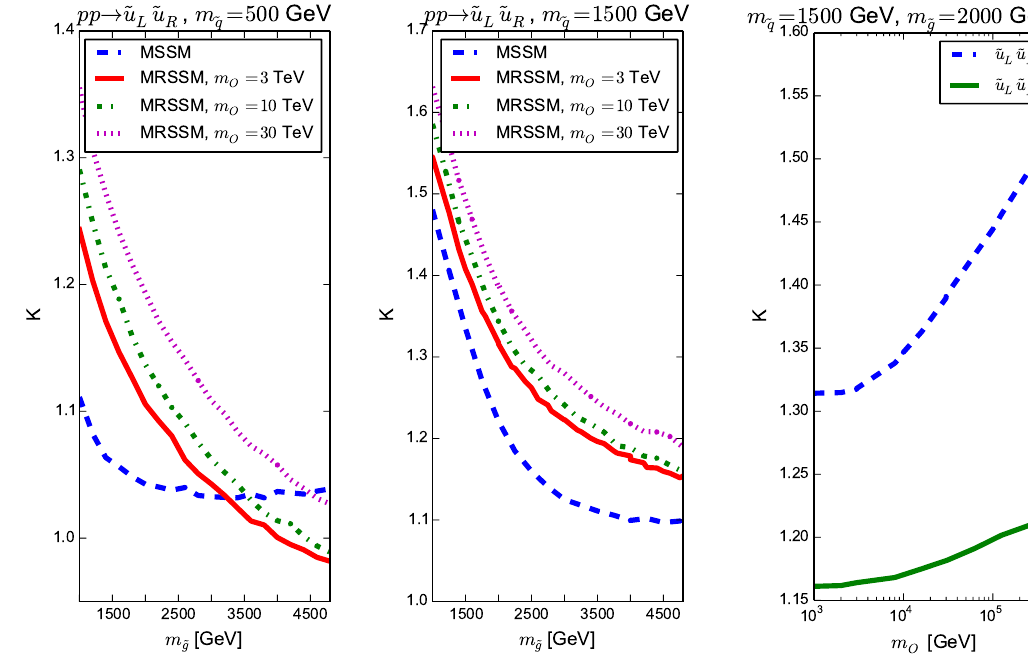
Figure 8. Comparison of K-factor dependence on the gluino mass between the MSSM and the MRSSM at di(cid:11)erent octet masses shown for two di(cid:11)erent squark masses.